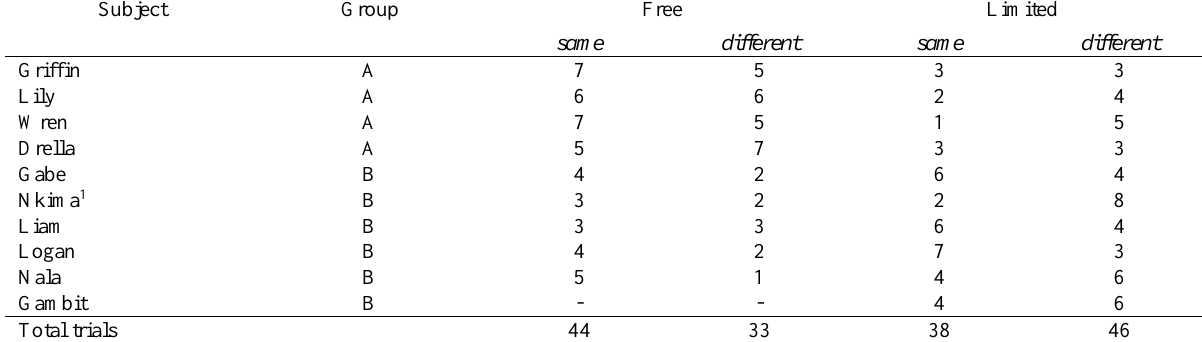
Focal Subjects’ Choices of the Same or Different Object as the Model Subjects in each Condition in Study 1